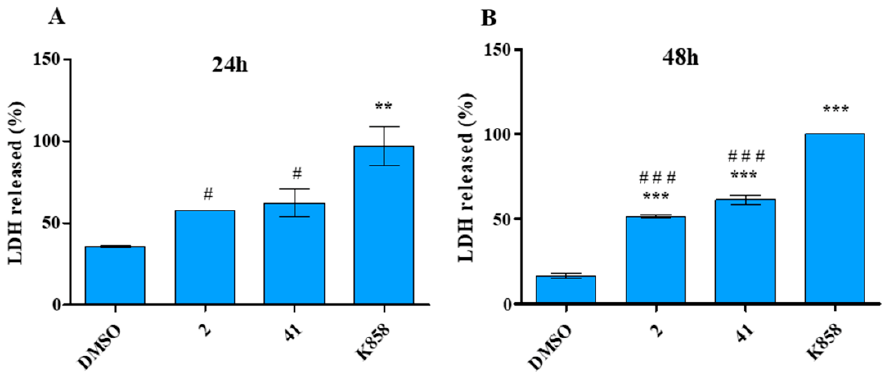
Figure 5. Cytotoxicity assay (LDH assay) of MCF7 cells treated with vehicle (DMSO), 2 (1.5 µ M), 41 (5 µ M), and K858 (10 µ M) for 24 ( A ) and 48 h ( B ). ( A ): ** p < 0.0051 DMSO vs. K858; # p < 0.05 2 and 41 vs. K858. ( B ): *** p < 0.0001 DMSO vs. Eg5 inhibitors; ### p < 0.001 K858 vs. 2 and 41. LDH leakage is reported as percentage. Data are presented as the mean ± SD of three separate